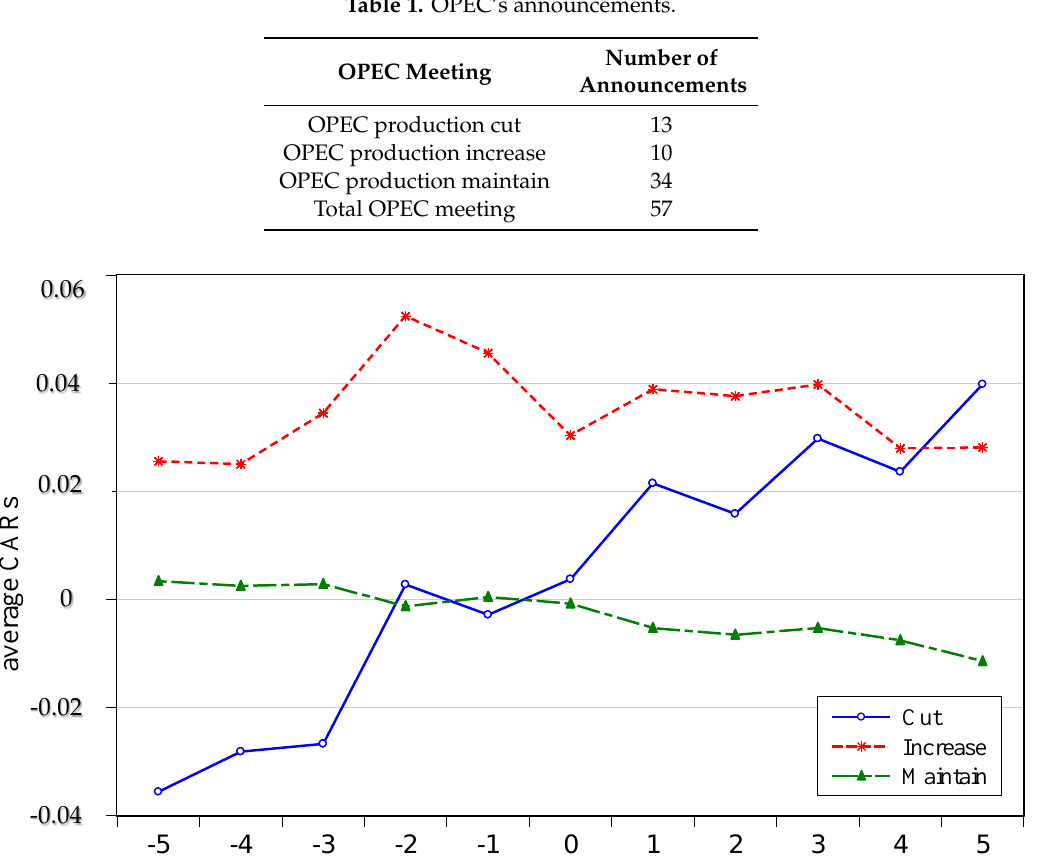
Figure 3. Average CARs of the Brent spot prices for OPEC’s announcements from five days before the event to five days after the event.